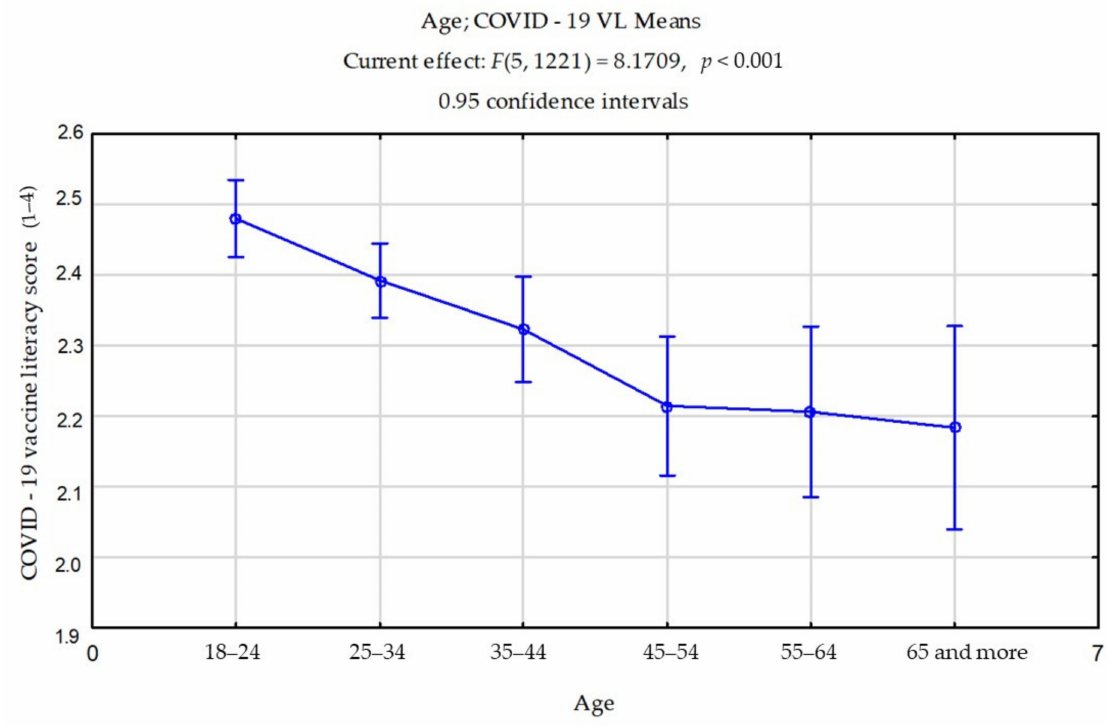
Figure 1. COVID-19 VL level considering age ( n = 1227). Table 3. COVID-19 functional and interactive-critical VL level considering age ( n =